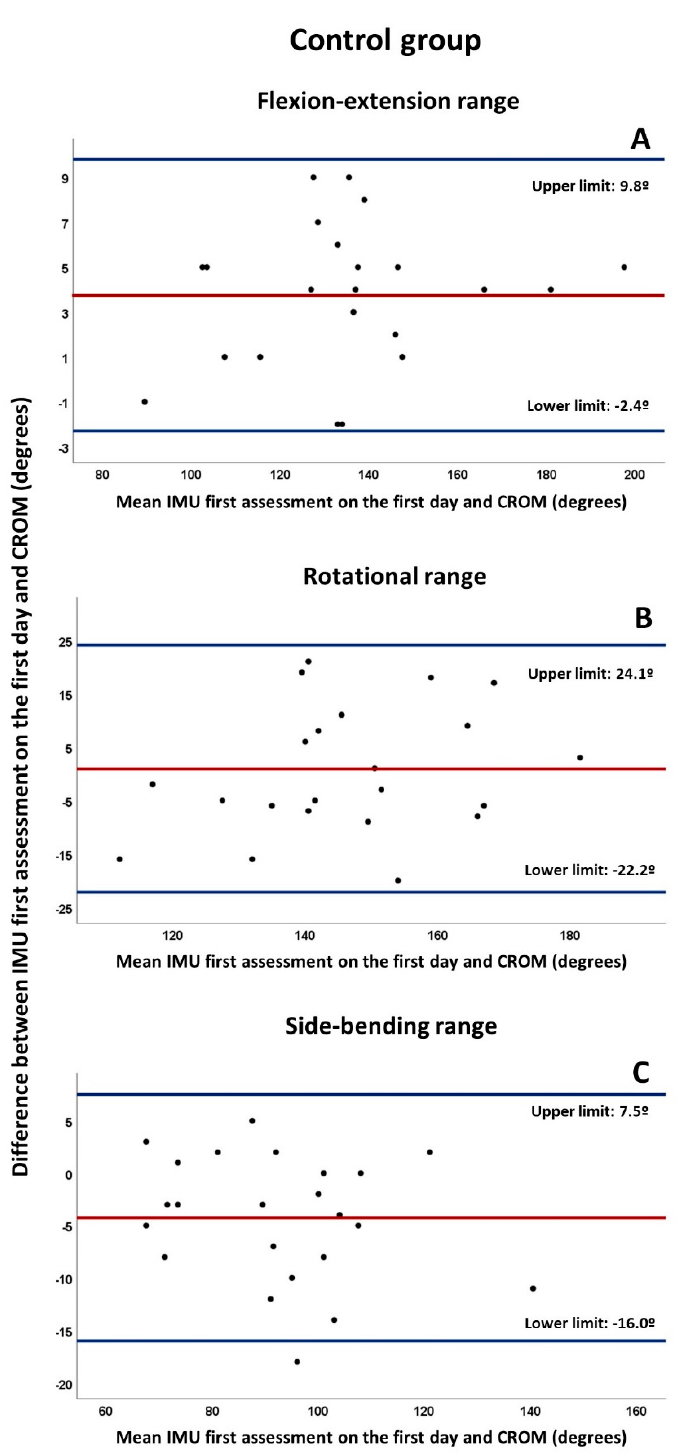
Figure 3. Bland–Altman plots for craniocervical ranges of the Control group measured by IMU first assessment on the first day and the CROM in ( A ) flexion-extension range, ( B ) rotational range, ( C ) side-bending range. The red line indicates the mean bias, whereas the blue lines refer to its upper and lower limits (mean ± 1.96 standard deviation). All plots were developed as follows: the Y axis corresponds to the differences between the paired values of both methods (IMU-CROM), whereas the X axis represents the respective value of the average of both (IMU + CROM/2).